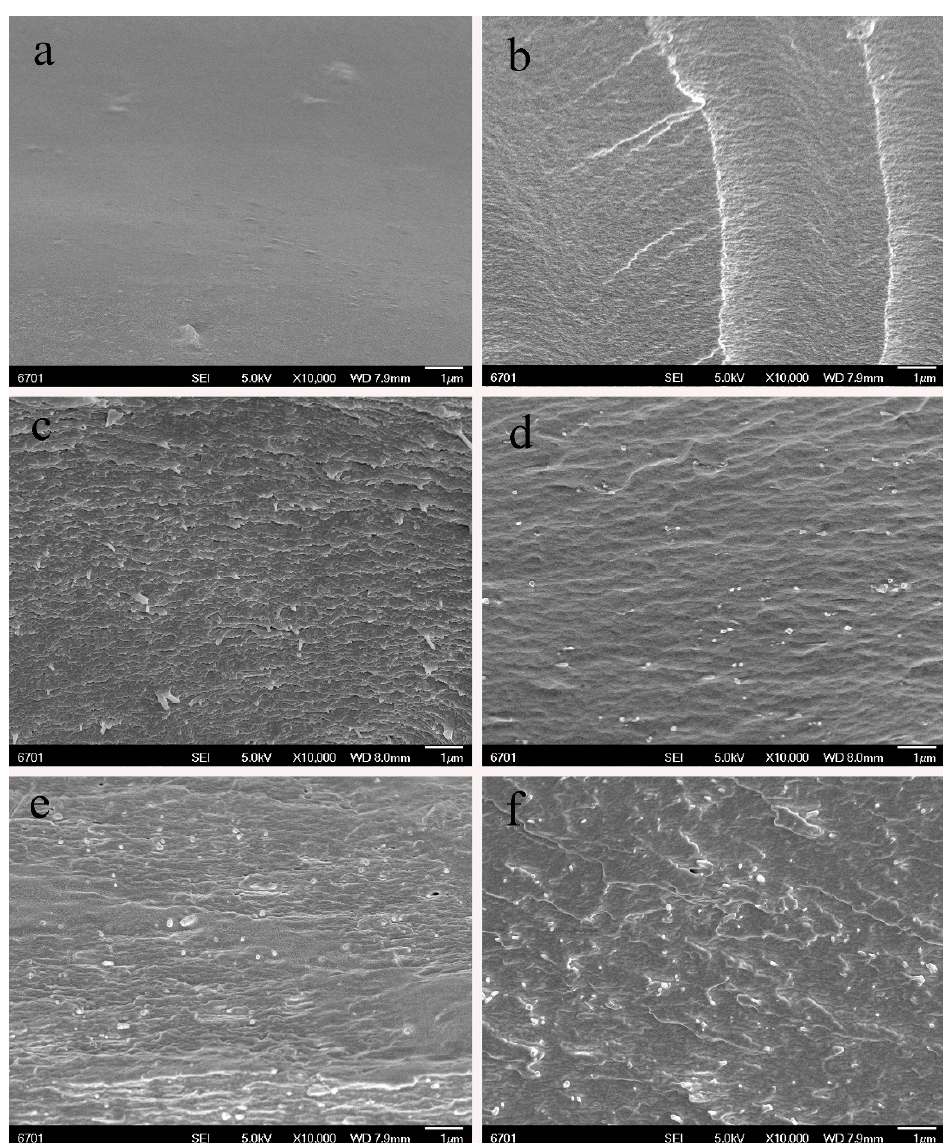
Figure 2. SEM micrographs of ( a ) pure FG, ( b ) FG/GE40, ( c ) FG/HT4, ( d ) FG/GE40/HTs4, ( e ) FG/HTs10 and ( f ) FG/GE40/HTs10.